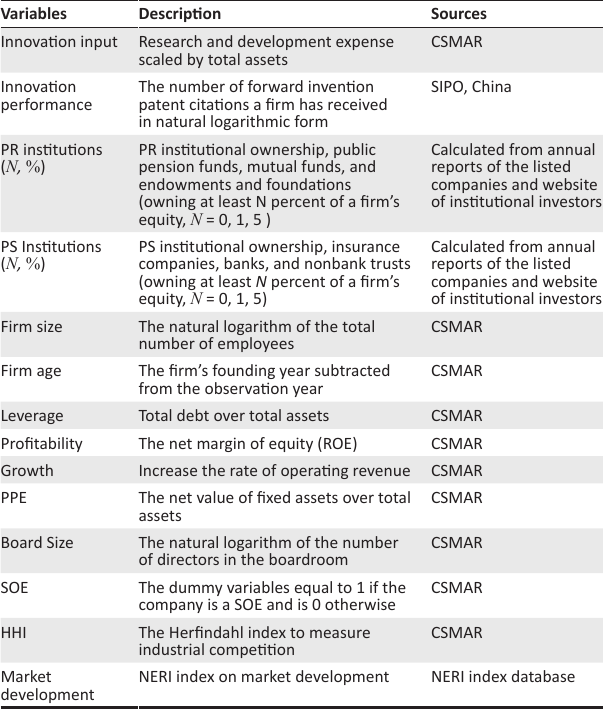
TABLE 1: Variables and data